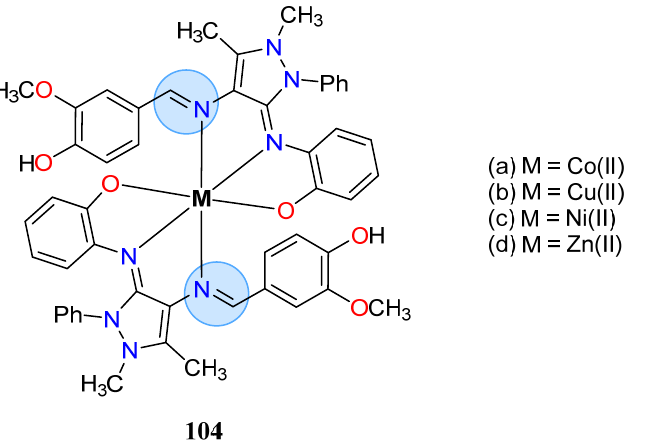
Figure Figure 53. Metal(II) complexes with a tridentate Schiff base derived from 4 ‐ hydroxy ‐ 3 ‐ methoxyben ‐ zylidine ‐ 4 ‐ aminoantipyrine studied for their antimicrobial activity.